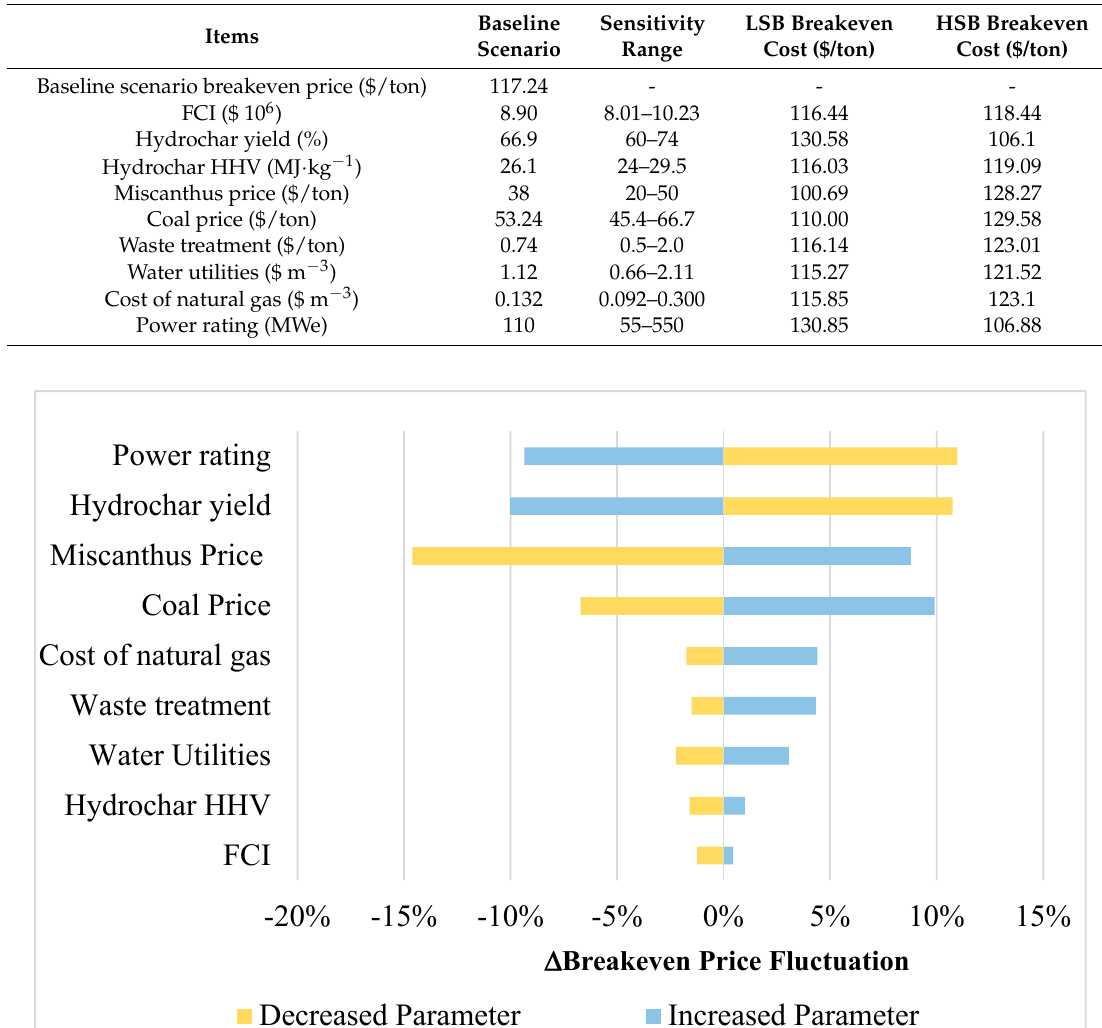
Table 6. Parameter ranges for sensitivity analysis used to determine breakeven cost ranges.